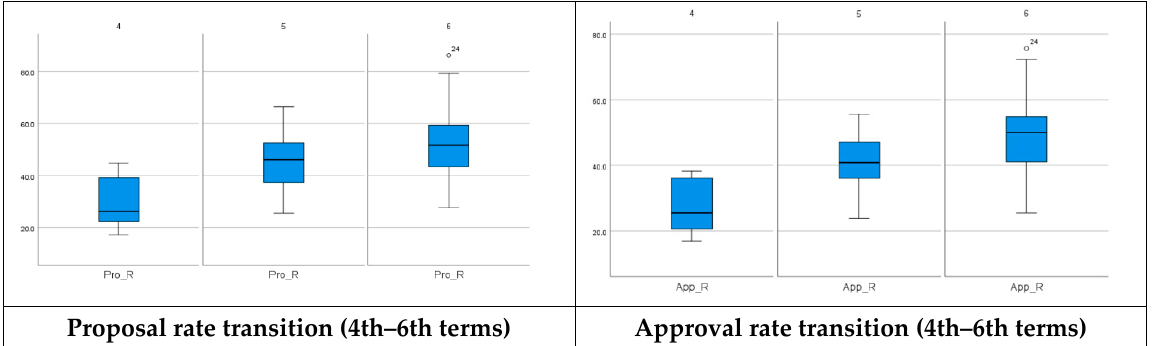
Figure 2. Analysis framework.